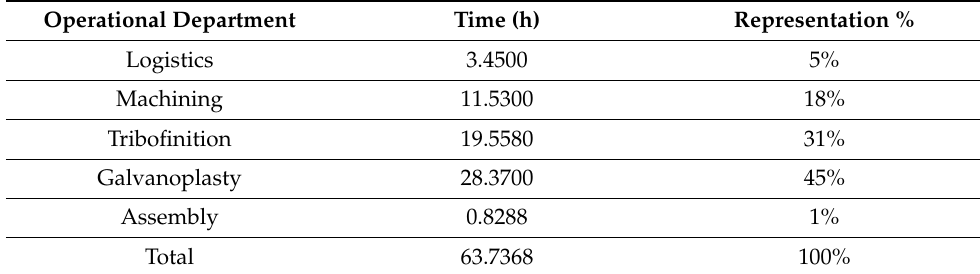
Table 8. Time consumption by operational